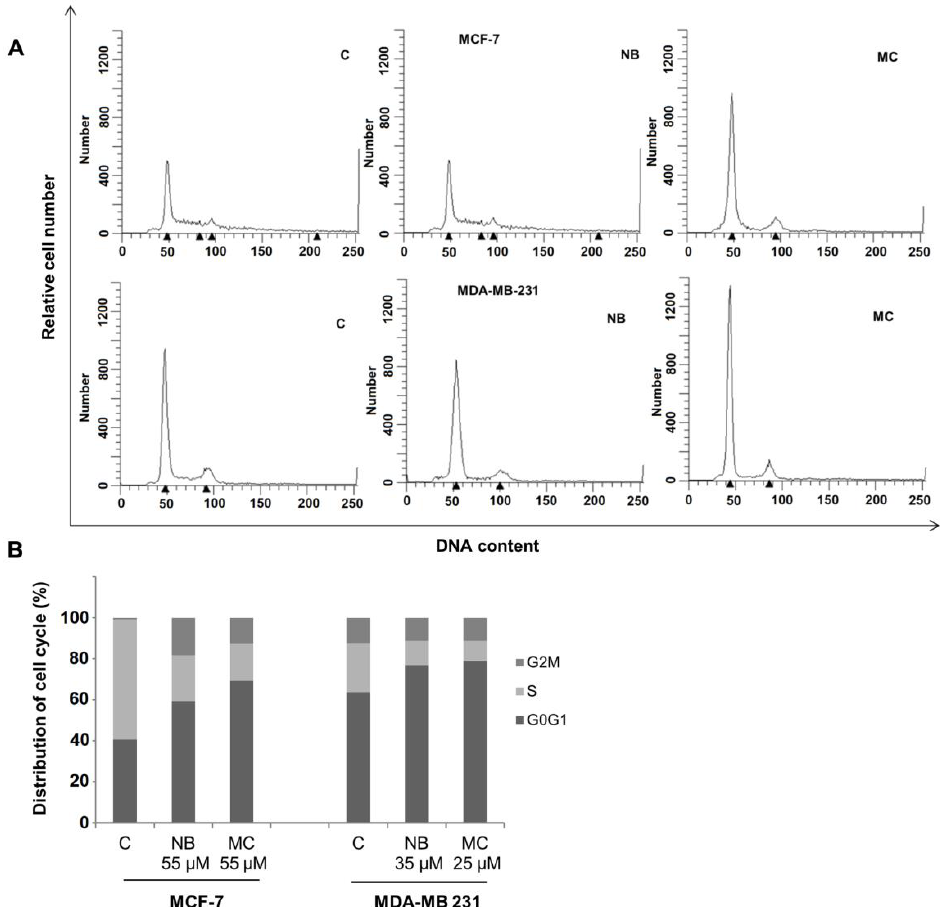
Figure 10. Flow cytometry analysis of the cycle profile of breast cancer cells. The proliferative data are expressed by the percentage of cells across the various phases of the cell cycle. ( A ) DNA content: DNA of individual cells; Relative cell number: distribution of cells across the cell cycle phases. MCF-7 treated with NB 55 µM and MC 35 µM, MDA-MB-231 treated with NB 55 µM and MC 25 µM, for 24 h. ( B ) Quantitative analysis of the fraction of gated cells at G0/G1, S and G2/M phases. The results are representative of three independent experiments. C = control.